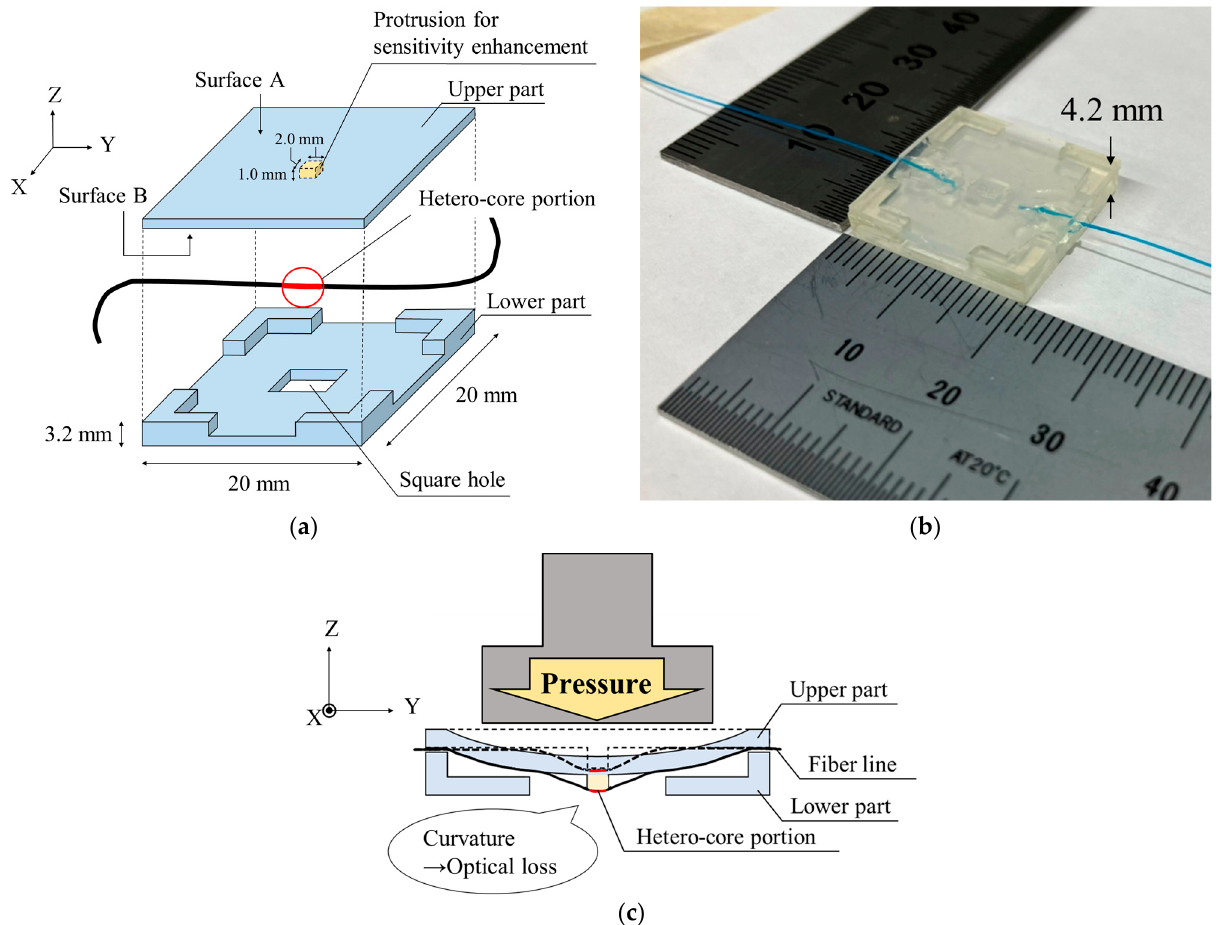
Figure 2. Pressure sensor using hetero-core fiber optics based on conversion mechanism from the pressure to the bending on the hetero-core portion: ( a ) structure of the pressure sensor using hetero- core fiber optics; ( b ) the hetero-core fiber-optic pressure sensor; ( c ) cross-section of the pressure sensor before and after pressurization.